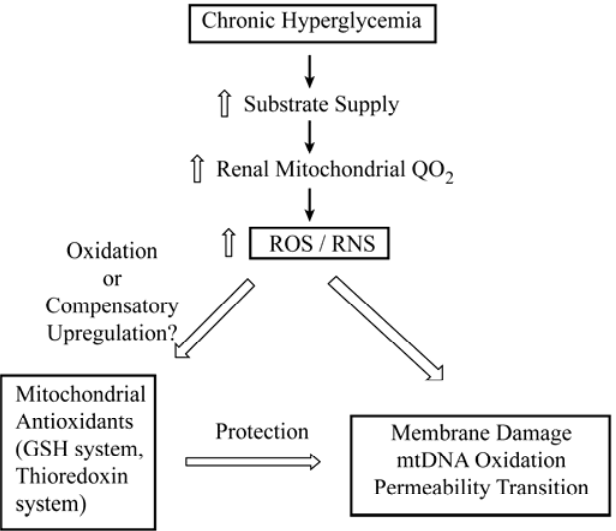
Figure 1. General scheme of major events leading from chronic hyperglycemia to mitochondrial dysfunction. Abbreviations: GSH, glutathione; RNS, reactive nitrogen species; ROS, reactive oxygen